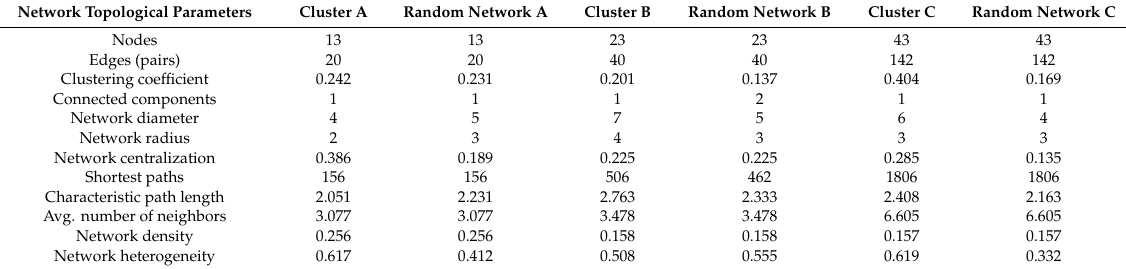
Table 6. Network topological parameters of the three clusters, performed by Cytoscape V.3.5., and the topological parameters of the respective random networks created by Network Randomizer